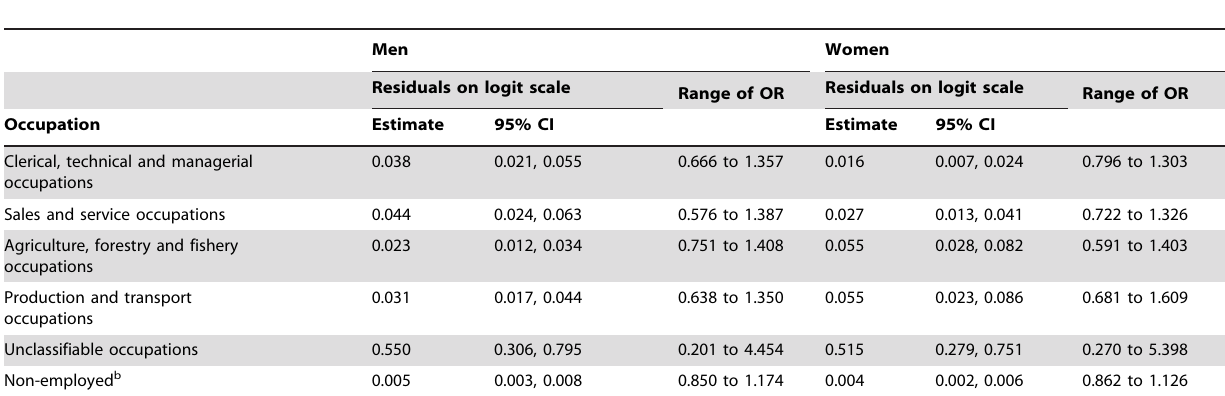
Table 4. Variation in all-cause mortality between 47 prefectures by occupation groups, Japan, 2005 a